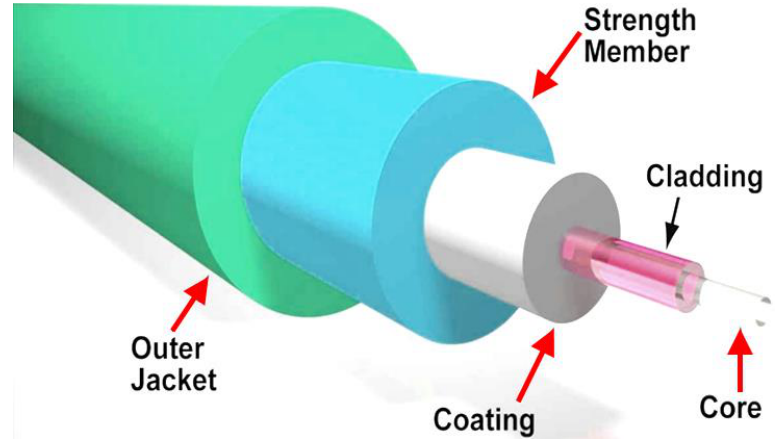
Figure 3. Structure of optical fiber.